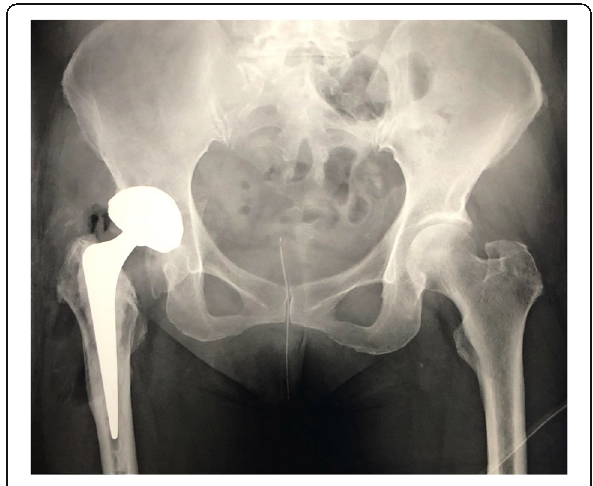
Fig. 5 Postoperative radiography showing the cemented femoral